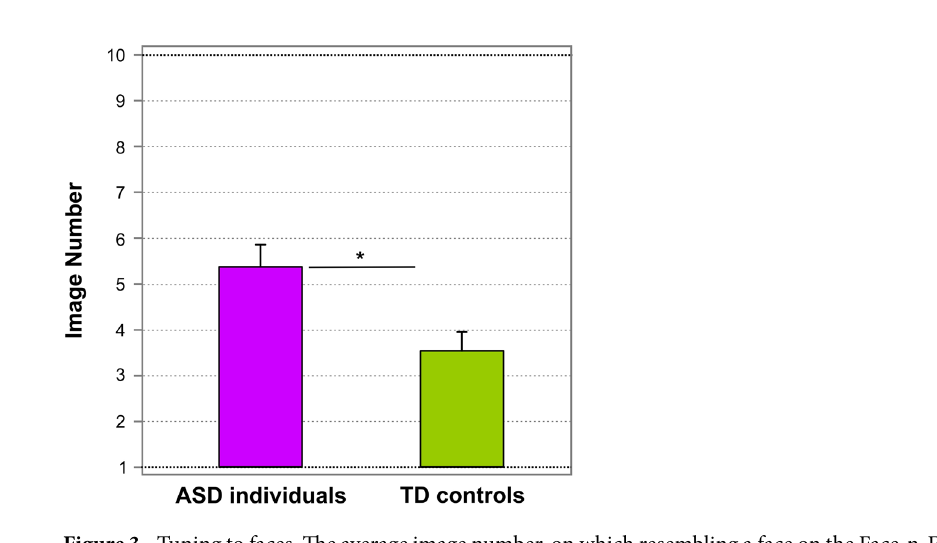
Figure 3. Tuning to faces. The average image number, on which resembling a face on the Face-n-Food task (face response) was initially reported, separately for ASD individuals and TD controls. Vertical bars represent SEM. Significant difference in thresholds for face tuning between ASD individuals and TD controls is indicated by